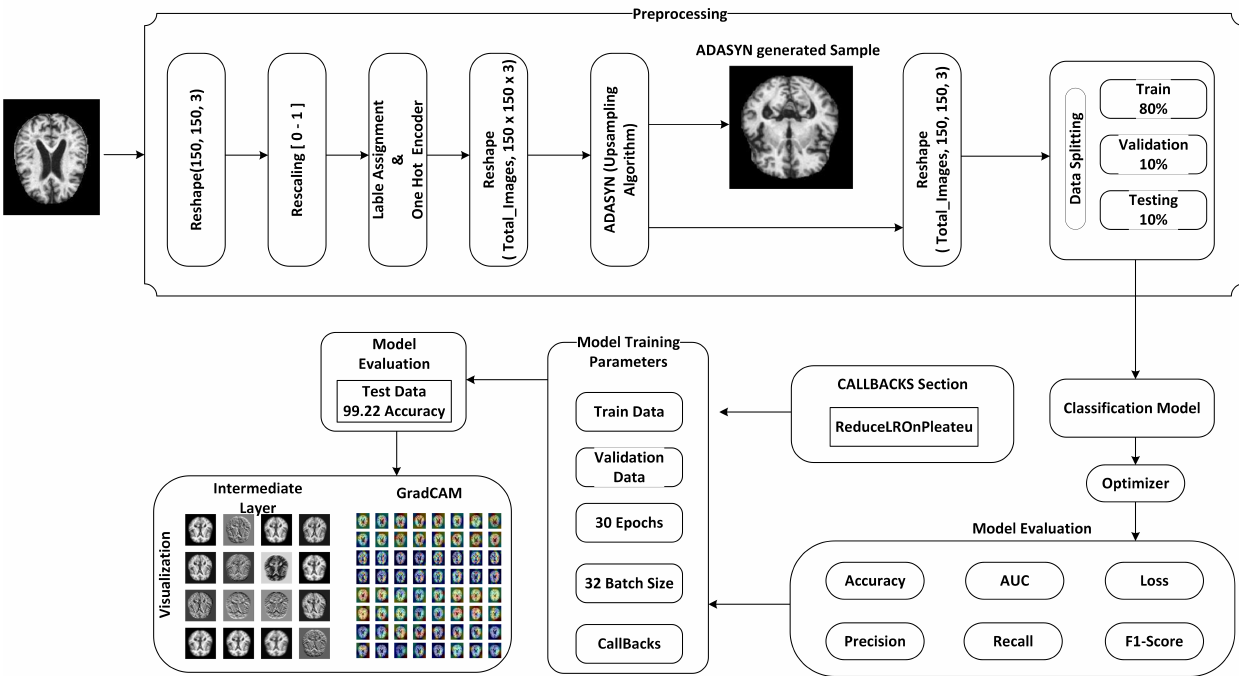
Figure 1. Methodology of the proposed DAD-Net that is used for early detection of AD.